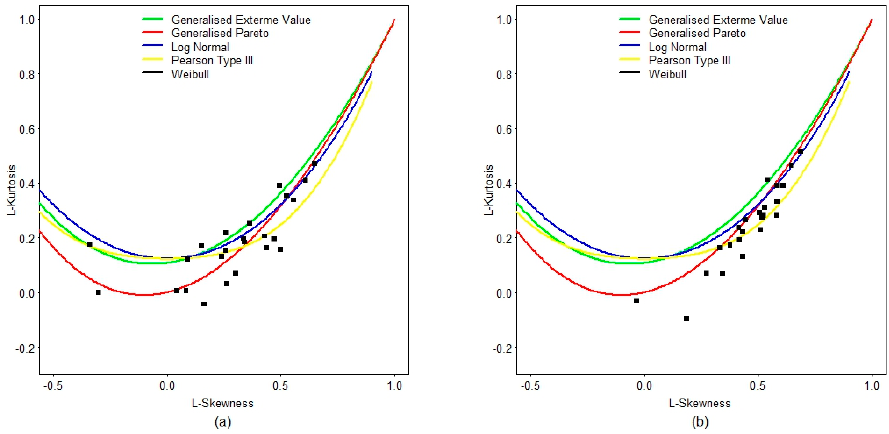
Figure 7. L-moment ratio diagrams for ( a ) AM series (left) and ( b ) POT flood series (right) for the river catchments in the GBR catchment in Australia.